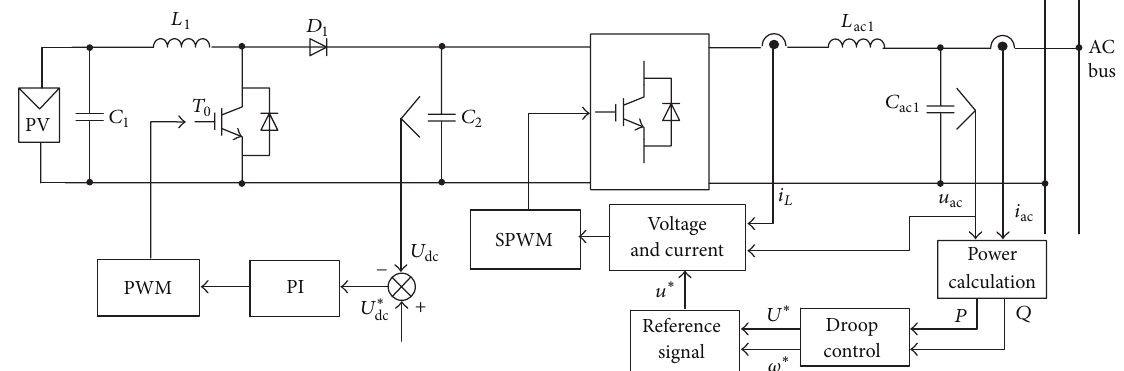
Figure 9: The control block of MG under islanded mode.